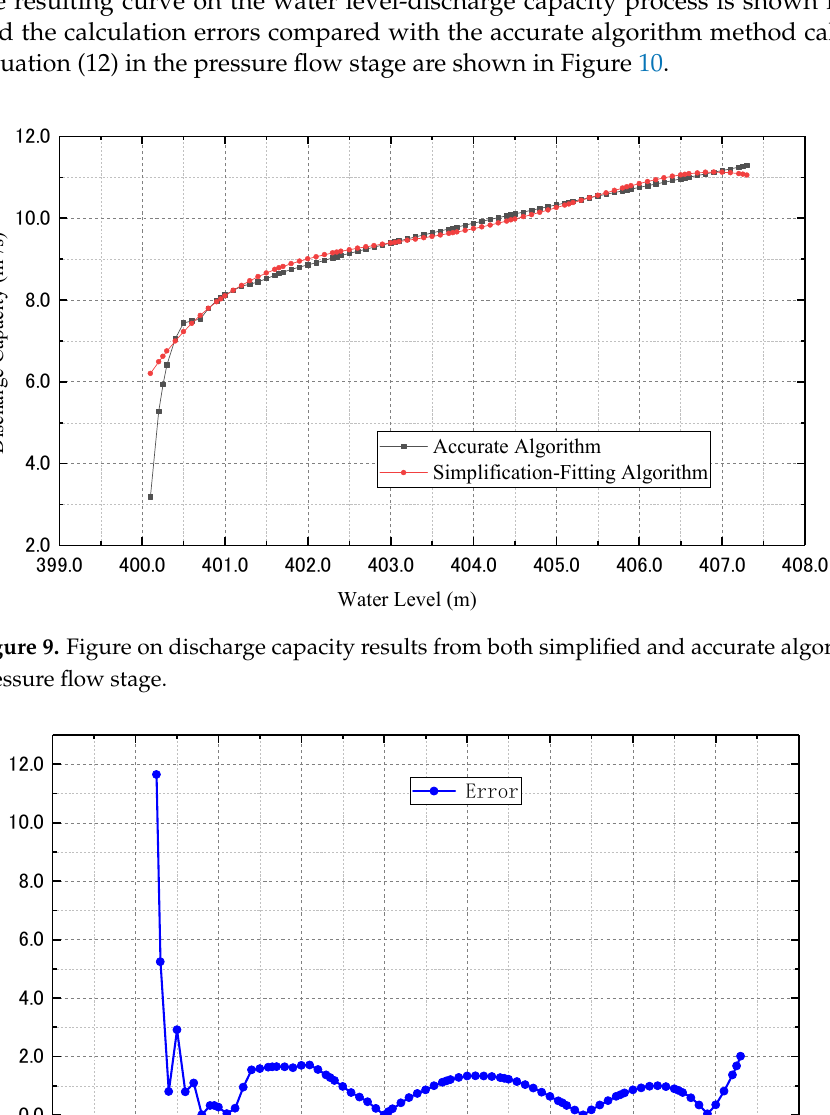
Table 4. Statistical table on errors between the simplified and accurate algorithms in the pressure flow stage.